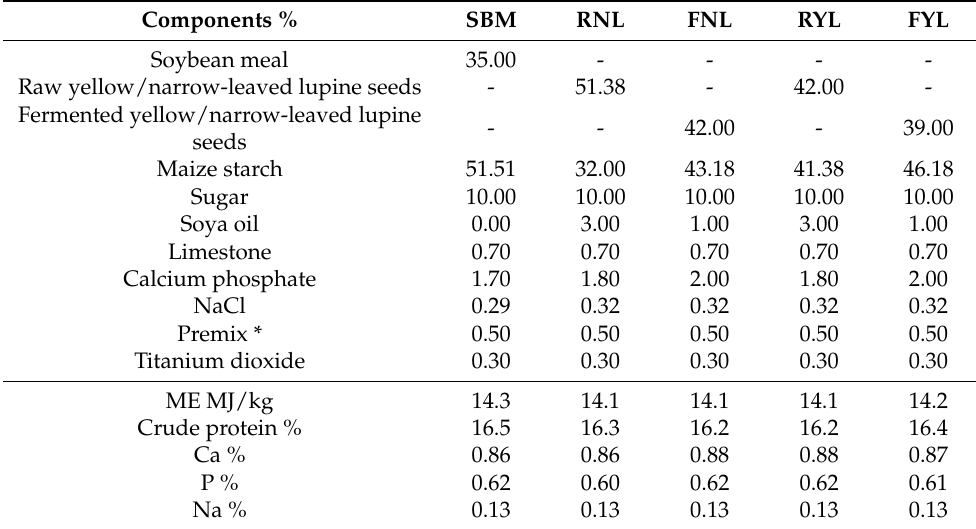
Table 3. The composition and calculated nutritional value of